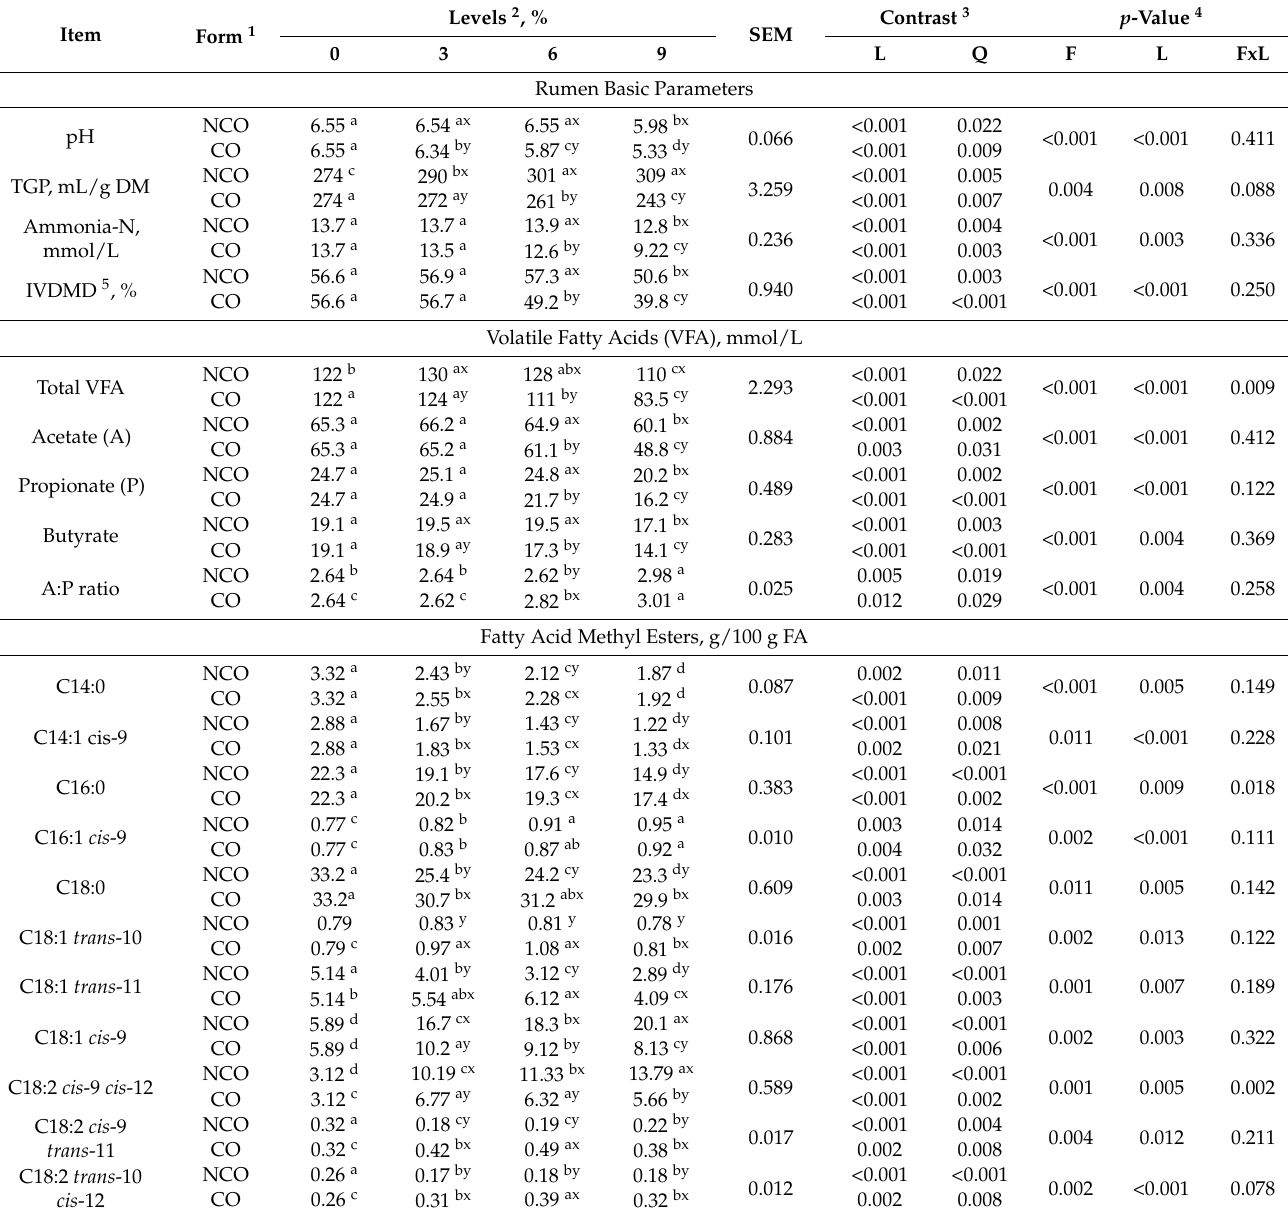
Table 5. Effect of the supplementation of raw and nanoemulsified corn oil on basic rumen parameters, volatile fatty acid, and fatty acid